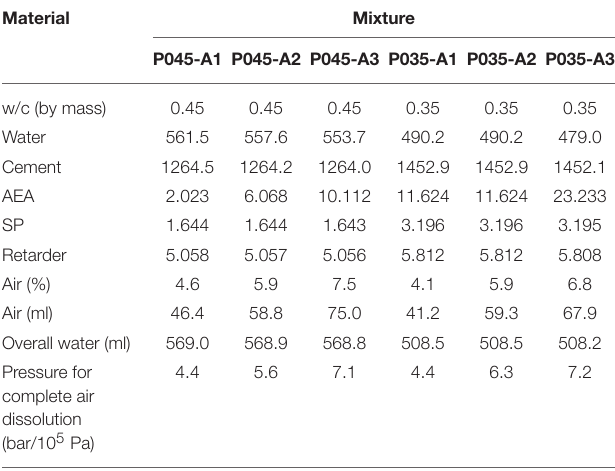
TABLE 1 | Mixture proportions and measured air contents (units in g/l, unless indicated otherwise). Material Mixture